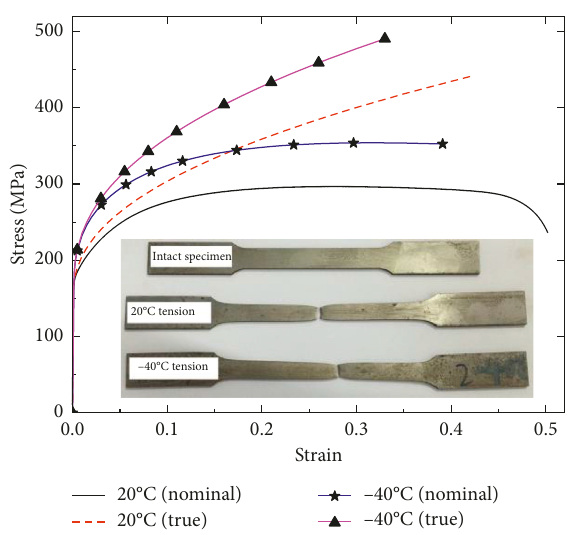
Figure 3: Stress-strain curves of the mild steel at different temperatures.